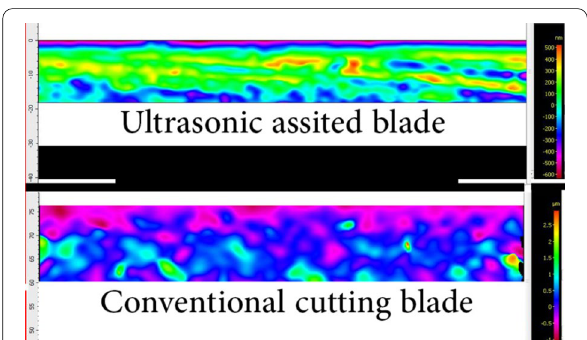
Figure 4 Images showing contour plots for blades after completing 38 cuts ultrasonically and